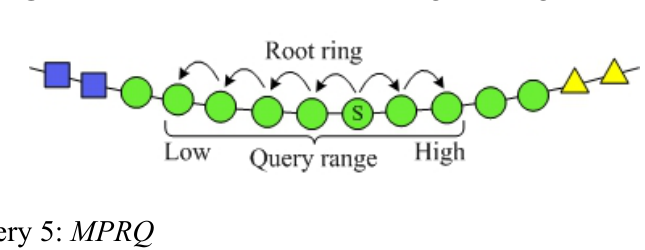
Figure 7. Node structure and message routing for